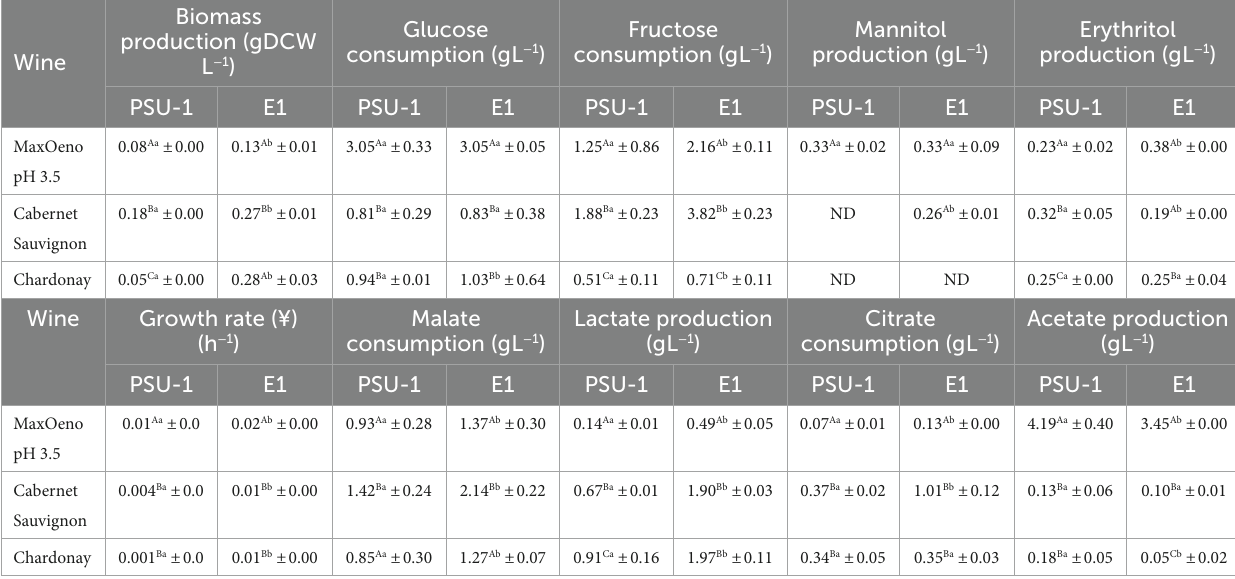
TABLE 1 Total consumption and production of compounds of strains PSU1 and E1 cultivated in different wines ( * ) ( φ ).